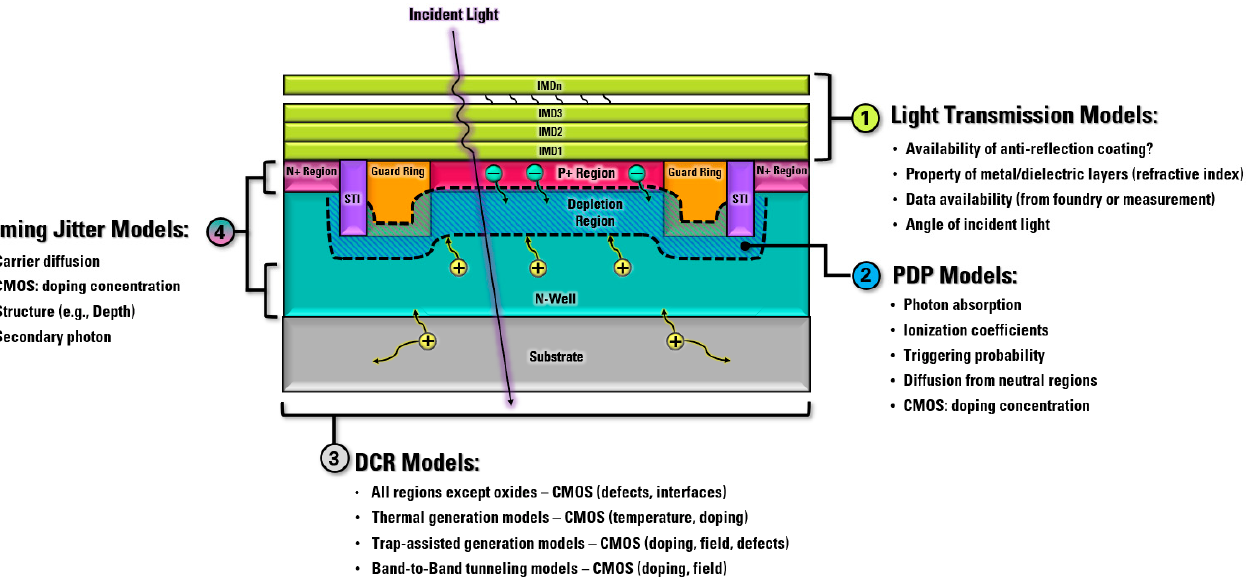
Figure 3. SPAD models graphical diagram with process-related parameters.